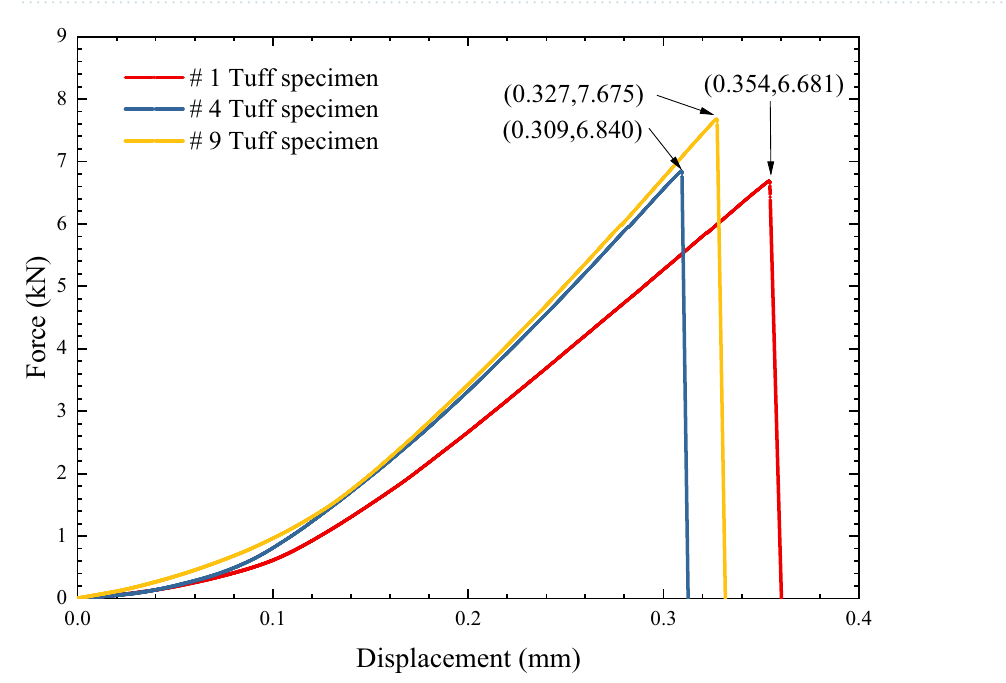
Figure 5. The force–displacement curve of tuff